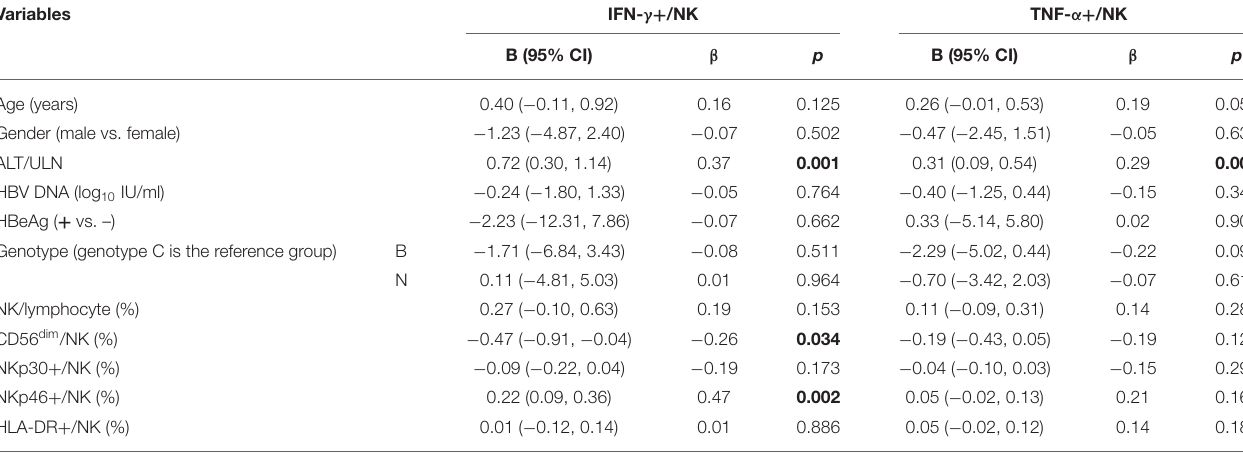
TABLE 2 | Factors associated with NK cells secreting cytokines in multivariate linear regression